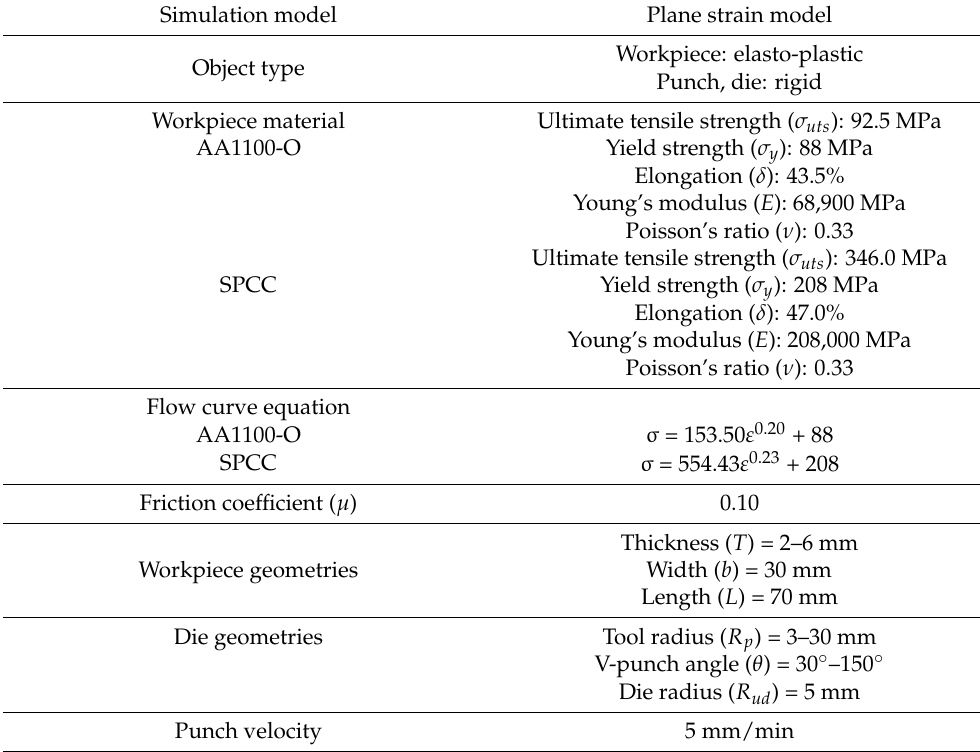
Table 1. Finite element simulation and experimental